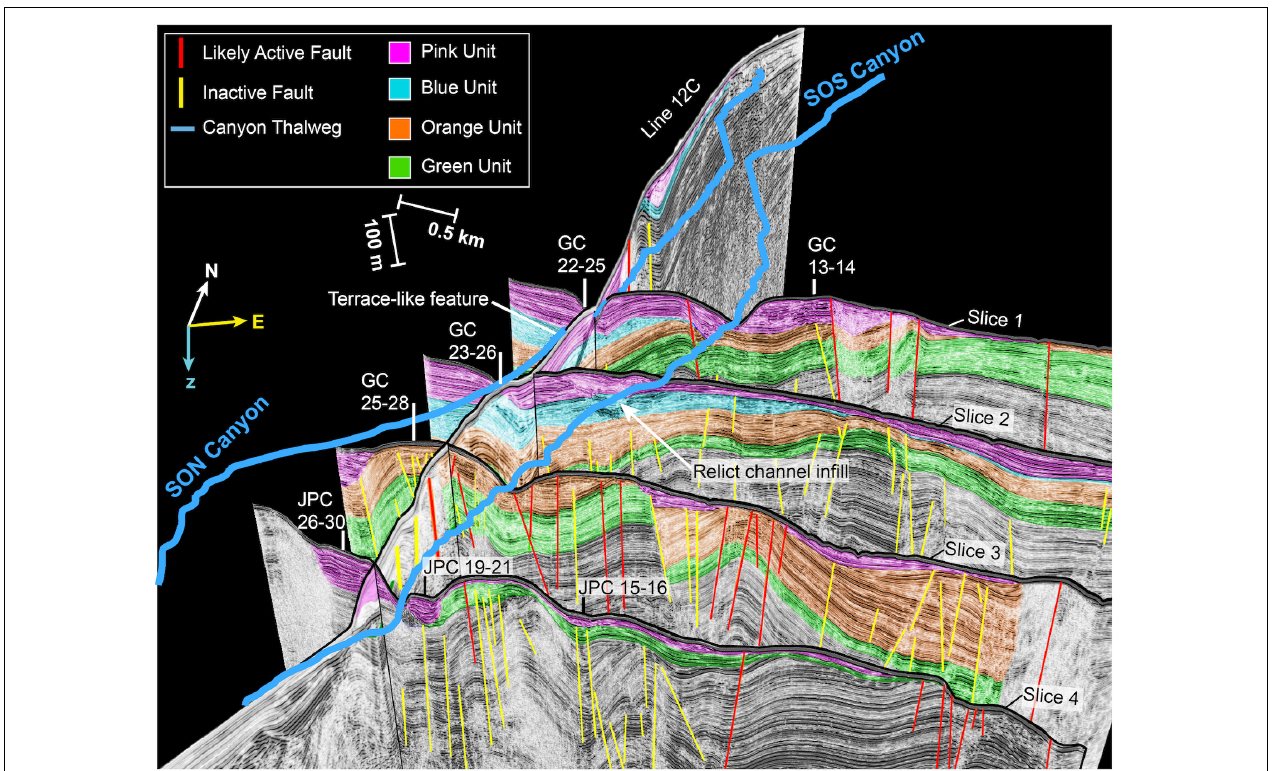
FIGURE 7 | A 3D seismic fence diagram with Sparker 2-D seismic line 12C and Sparker 3D slices. The locations of the two canyons are traced in blue. Colors denote sediment units, with the Pink unit as the youngest and the Green unit as the oldest. Likely active faults are shown in red and inactive faults are shown in yellow. Locations of cores are plotted as white or black lines. Vertical Exaggeration =